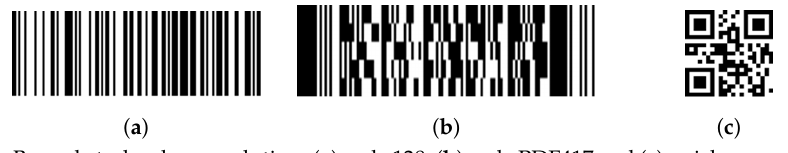
Figure 1. Barcode technology evolution: ( a ) code 128, ( b ) code PDF417 and ( c ) quick response (QR)